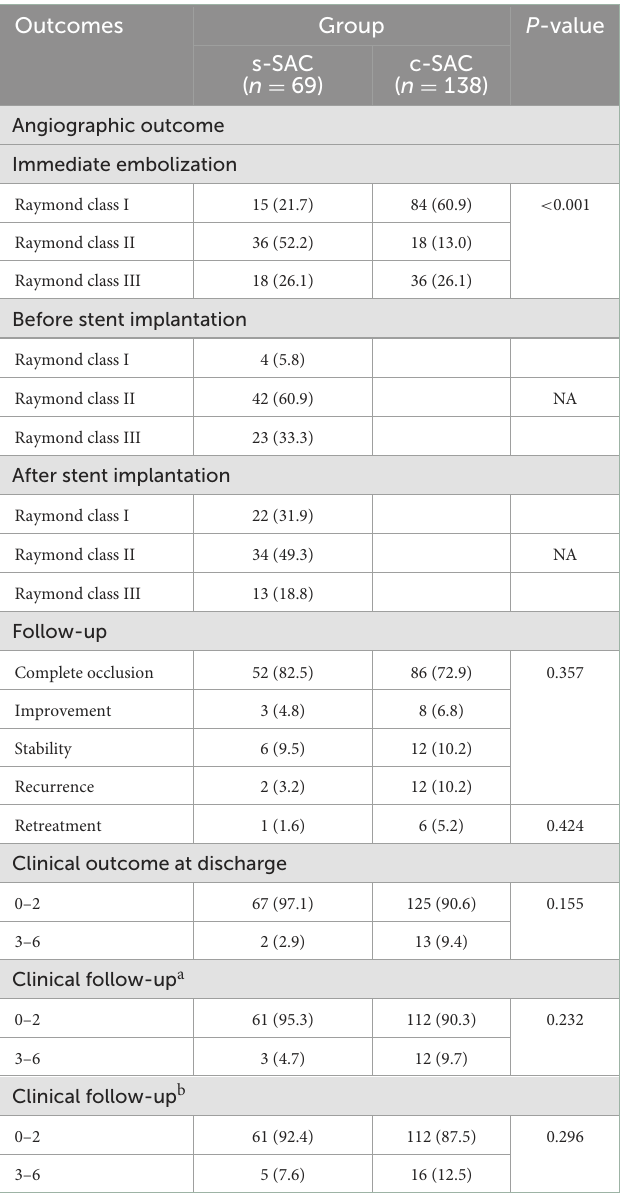
TABLE 3 Angiographic and clinical Outcomes. Outcomes Group